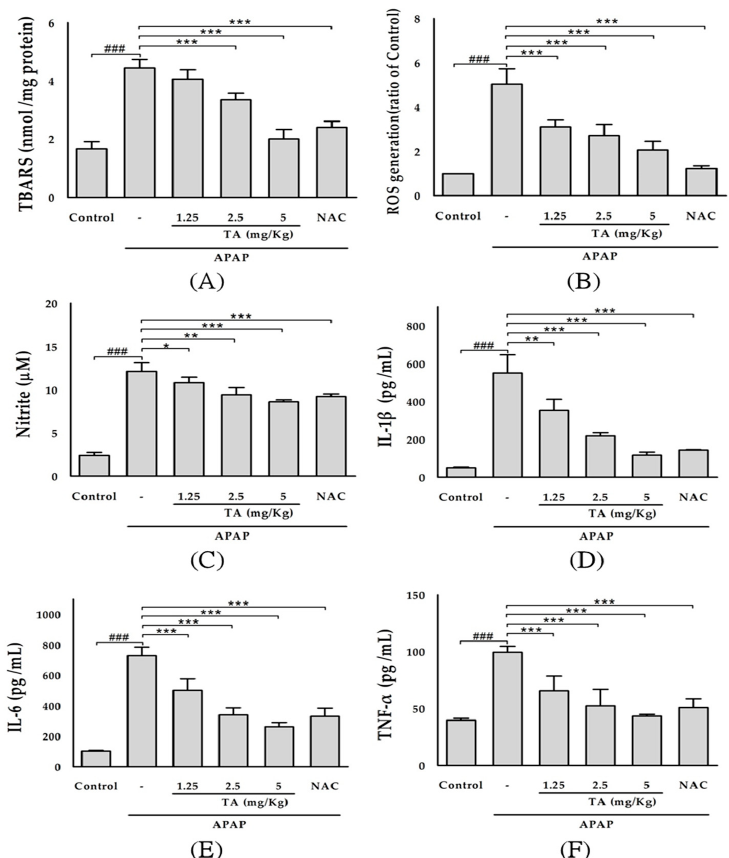
Figure 4. Effects of TA on liver lipid peroxides levels ( A ); Effects of TA on serum ROS ( B ); NO ( C ); IL-1 β ( D ); IL-6 ( E ); and TNF- α levels ( F ) in APAP-induced mice. The values are reported as the means ± S.E.M. of five mice per group. ### p < 0.01 compared with the control group; * p < 0.05, ** p < 0.01, and *** p <